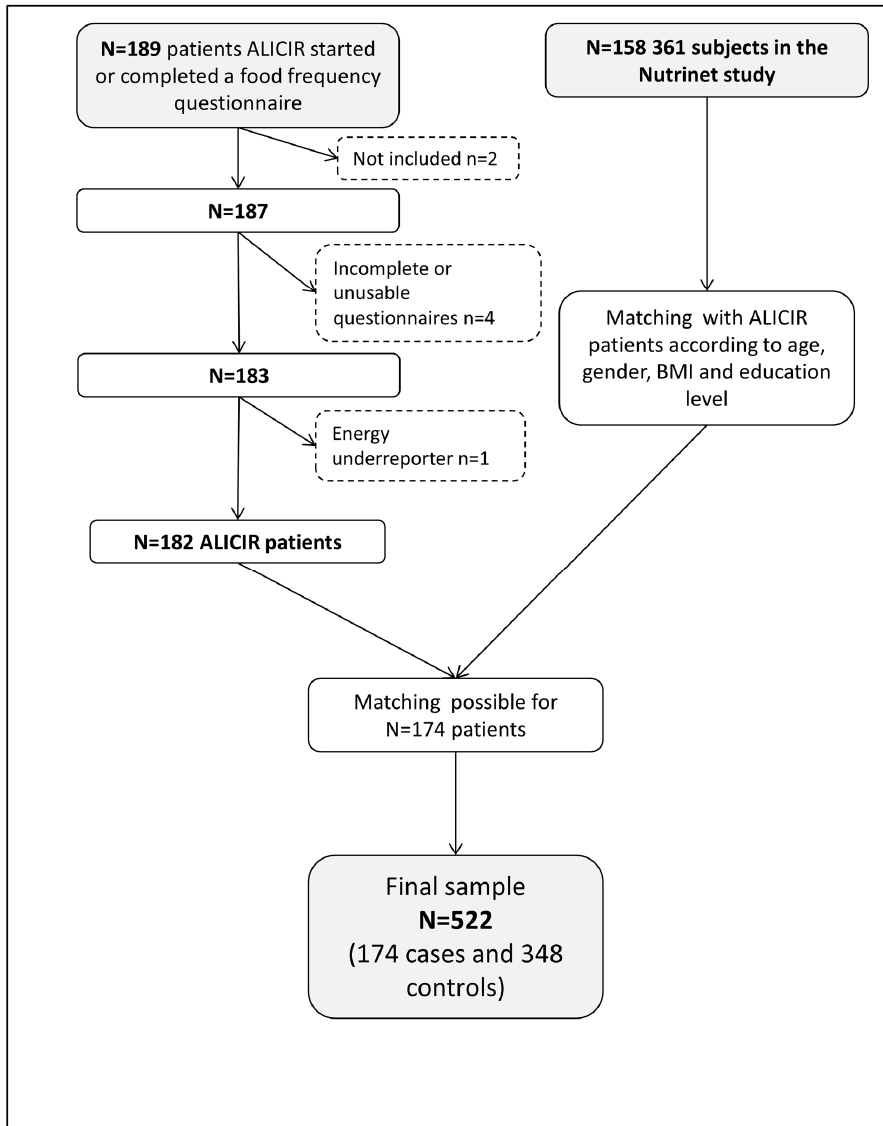
Figure 2. Flowchart of the study. Table 1. Comparison of sociodemographic characteristics for cases and controls ( N = 522).